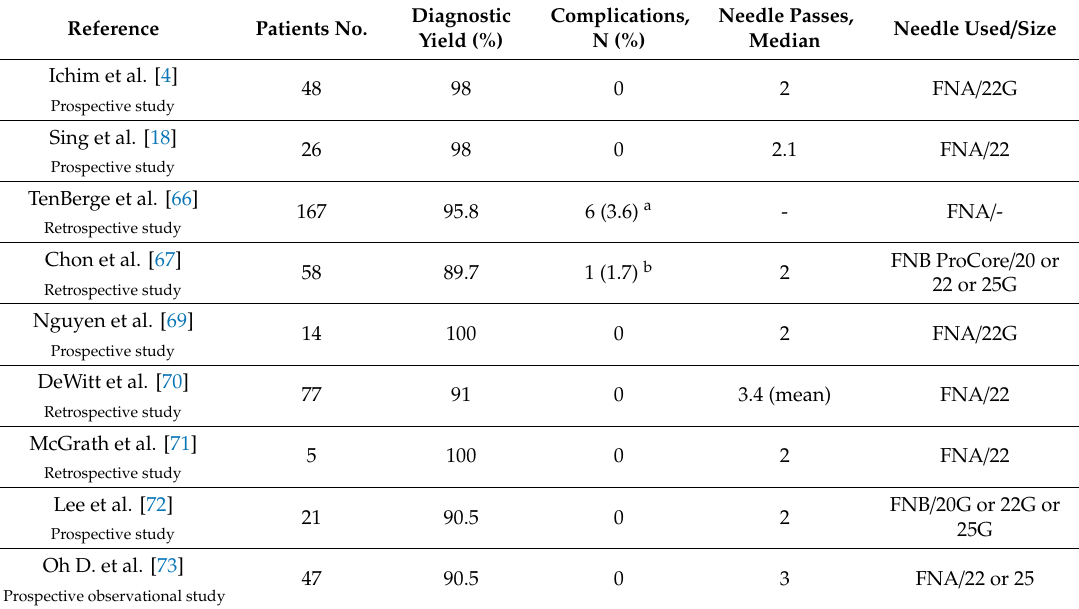
Table 5. Studies reporting the utility of EUS-guided liver biopsy in focal liver